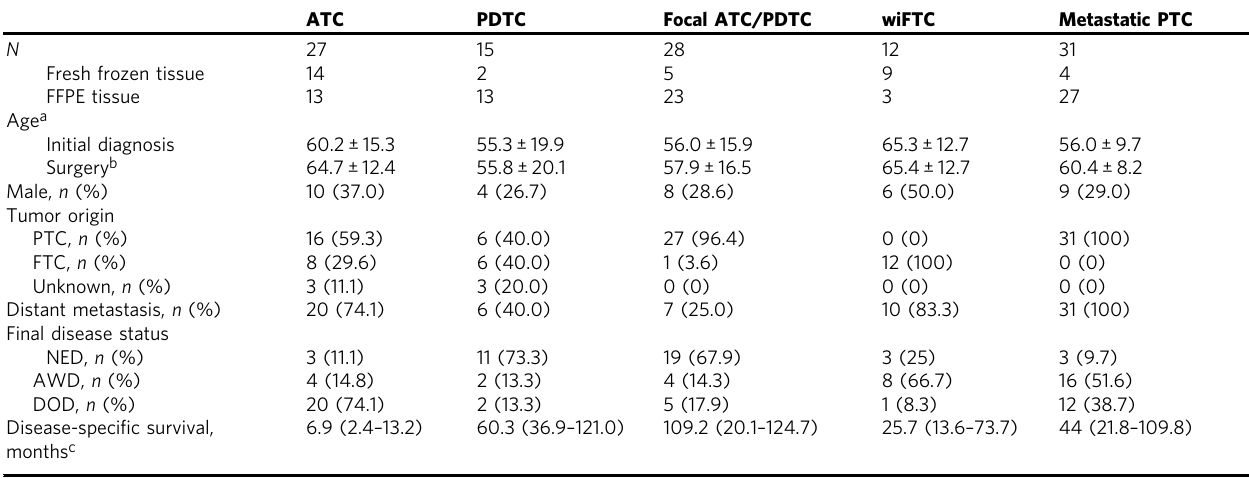
Table 1 Clinicopathological characteristics of patients according to the histology